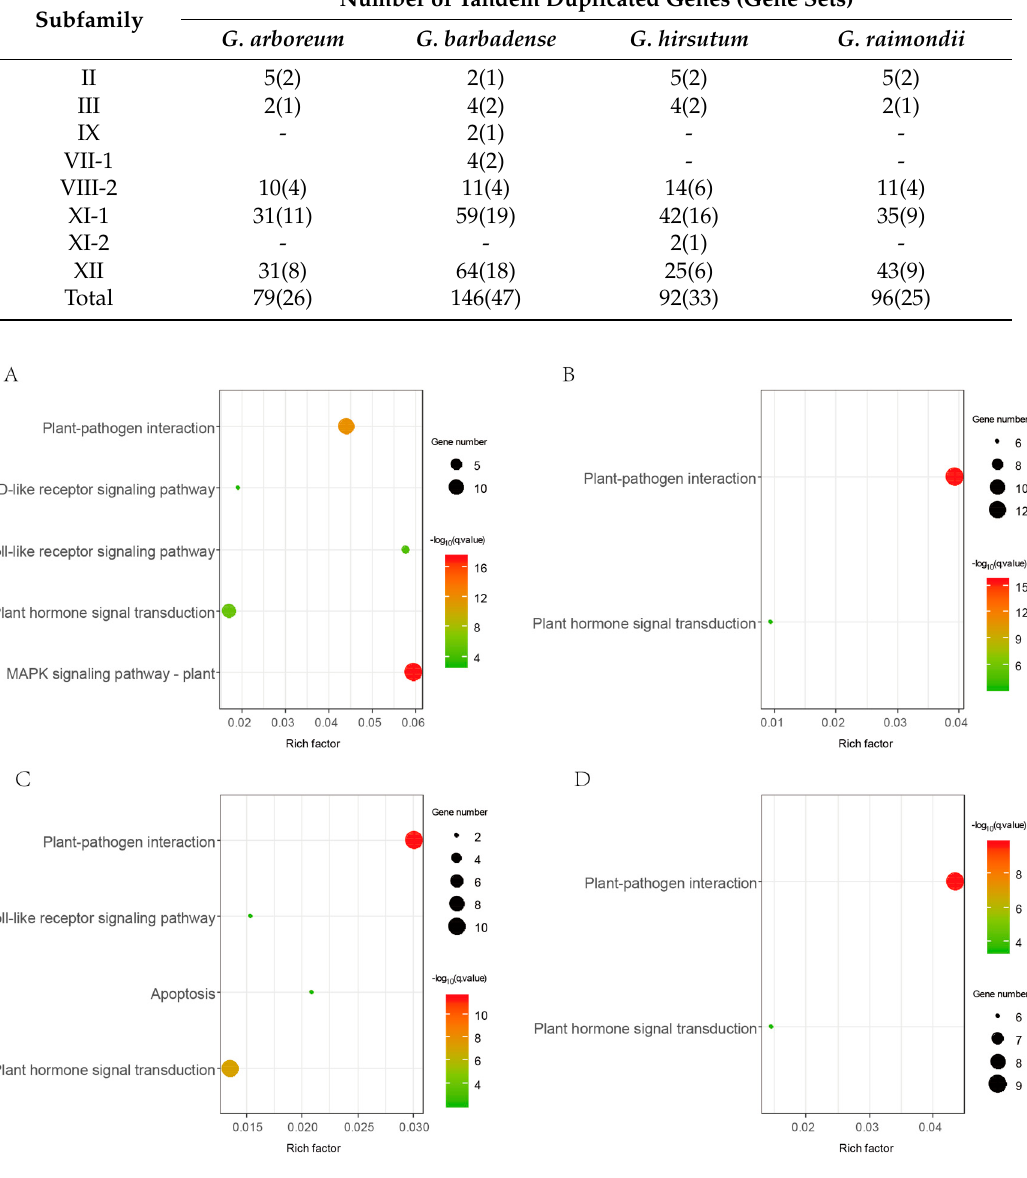
Figure 4. KEGG (Kyoto Encyclopedia of Genes and Genomes) pathway enrichment result of Gossypium LRR-RLK genes. Results of G. arboreum , G. barbadense , G. hirsutum, and G. raimondii were shown by ( A – D ) respectively.